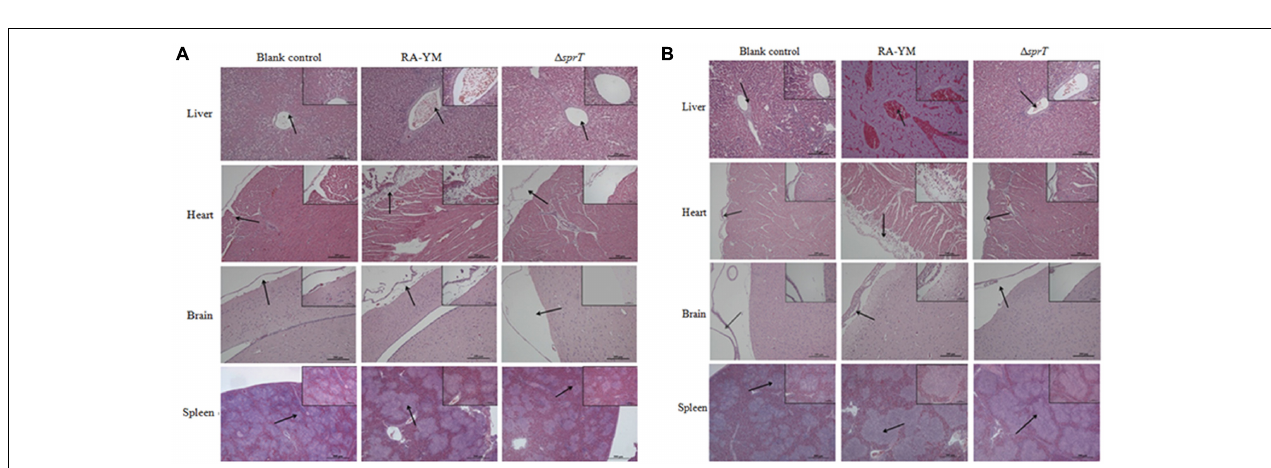
FIGURE 5 | Histopathological analysis of ducklings infected with wild-type strain RA-YM or mutant strain (cid:49) sprT . Tissue specimens were analyzed 24 h (A) and 48 h (B) post challenge.